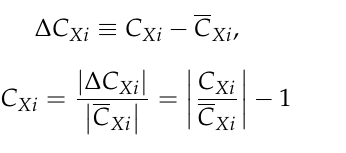
Table 29. Relative accuracy of landing longitudinal stability derivatives (percentage discrepancy % between extrapolation and CFD–RANS).